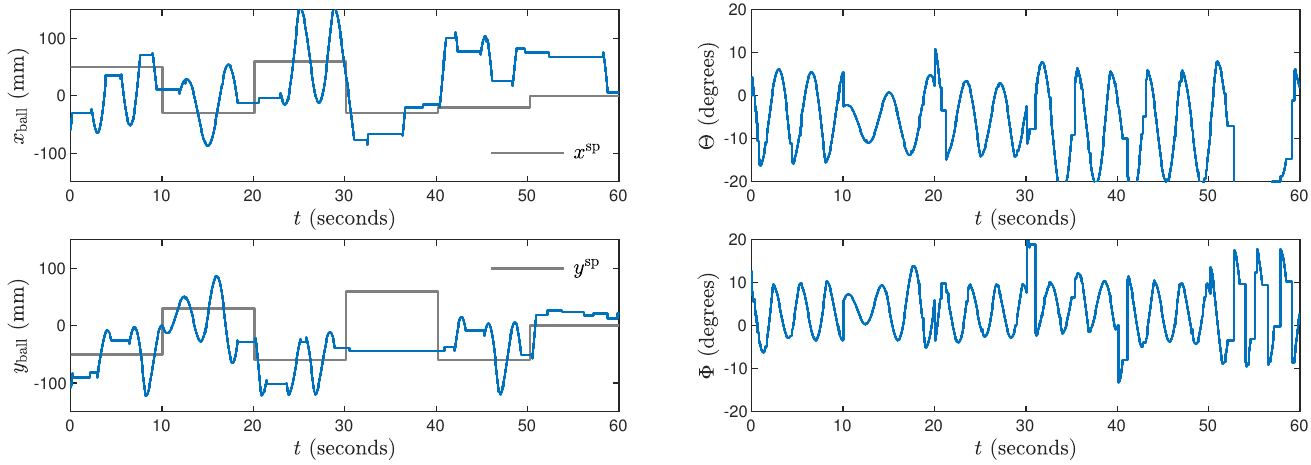
Figure 7. Experimental results of the PI algorithm.